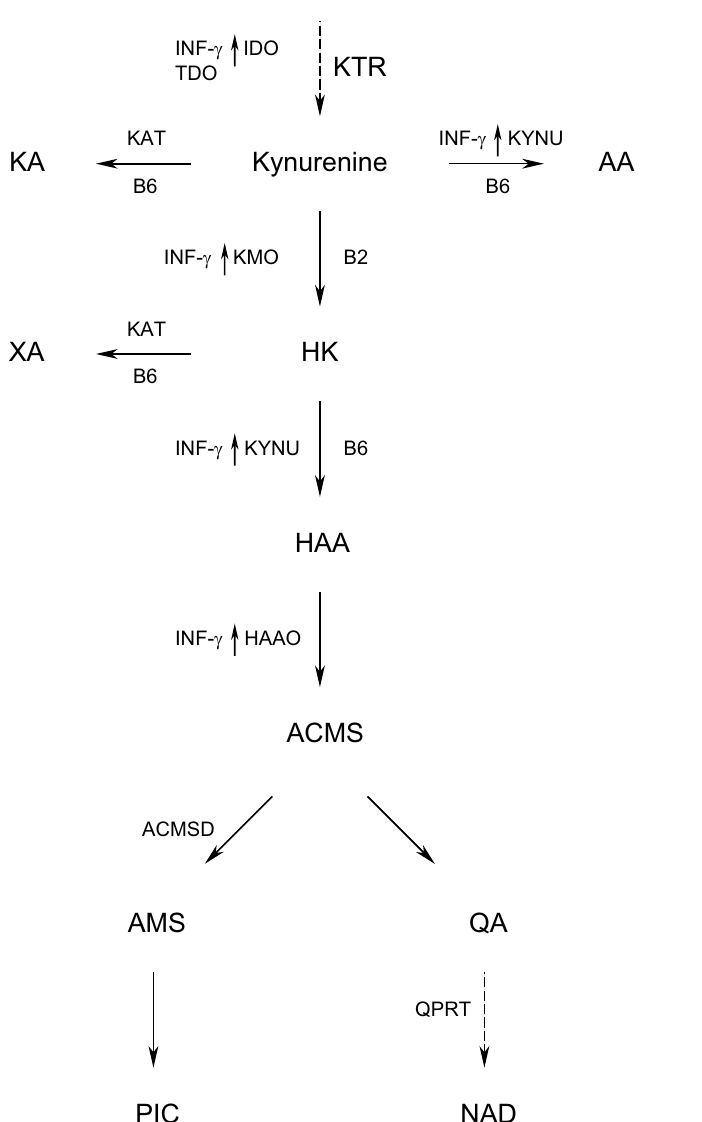
Blood samples and biochemical analyses. Serum/plasma was collected during the period 1974–2010, and all biospecimens were stored at ≤ − 80 °C until analysis, which was performed during 2012–2014. The sam- ples were shipped on dry ice to Bevital AS (http:// www. bevit al. no) in Bergen, Norway, where all biochemical analyses were performed. Briefly, circulating concentrations of tryptophan and kynurenine were obtained by mixing serum/plasma with ethanol to precipitate the proteins, and the supernatant was processed further before analysis by gas chro- matography–mass spectrometry (GC–MS) 33 using a Thermo Finnigan trace GC ultra system coupled to a Fisons